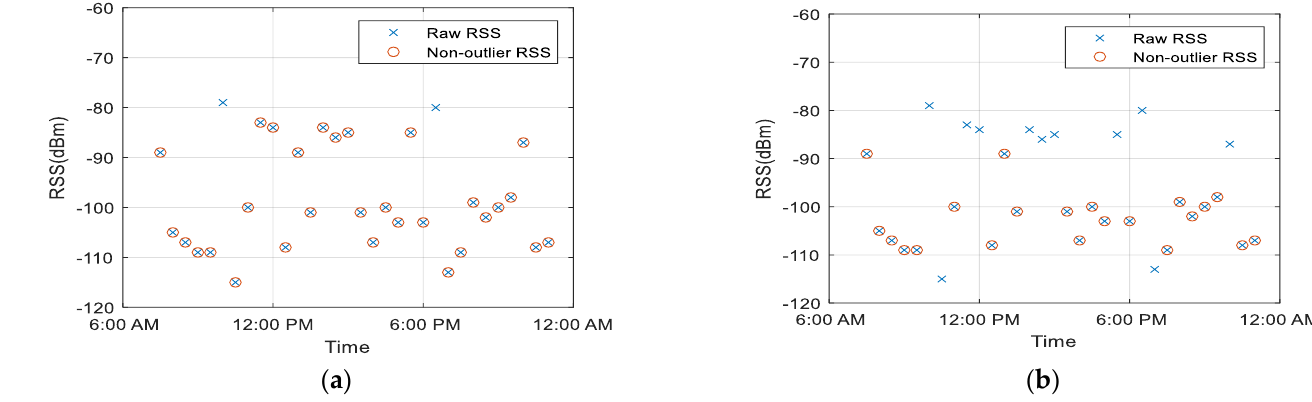
Figure 6. RSS outlier detection comparison for RSS Dataset 4. ( a ) 𝑆 𝑛 scale estimator, and ( b ) MAD scale estimator.